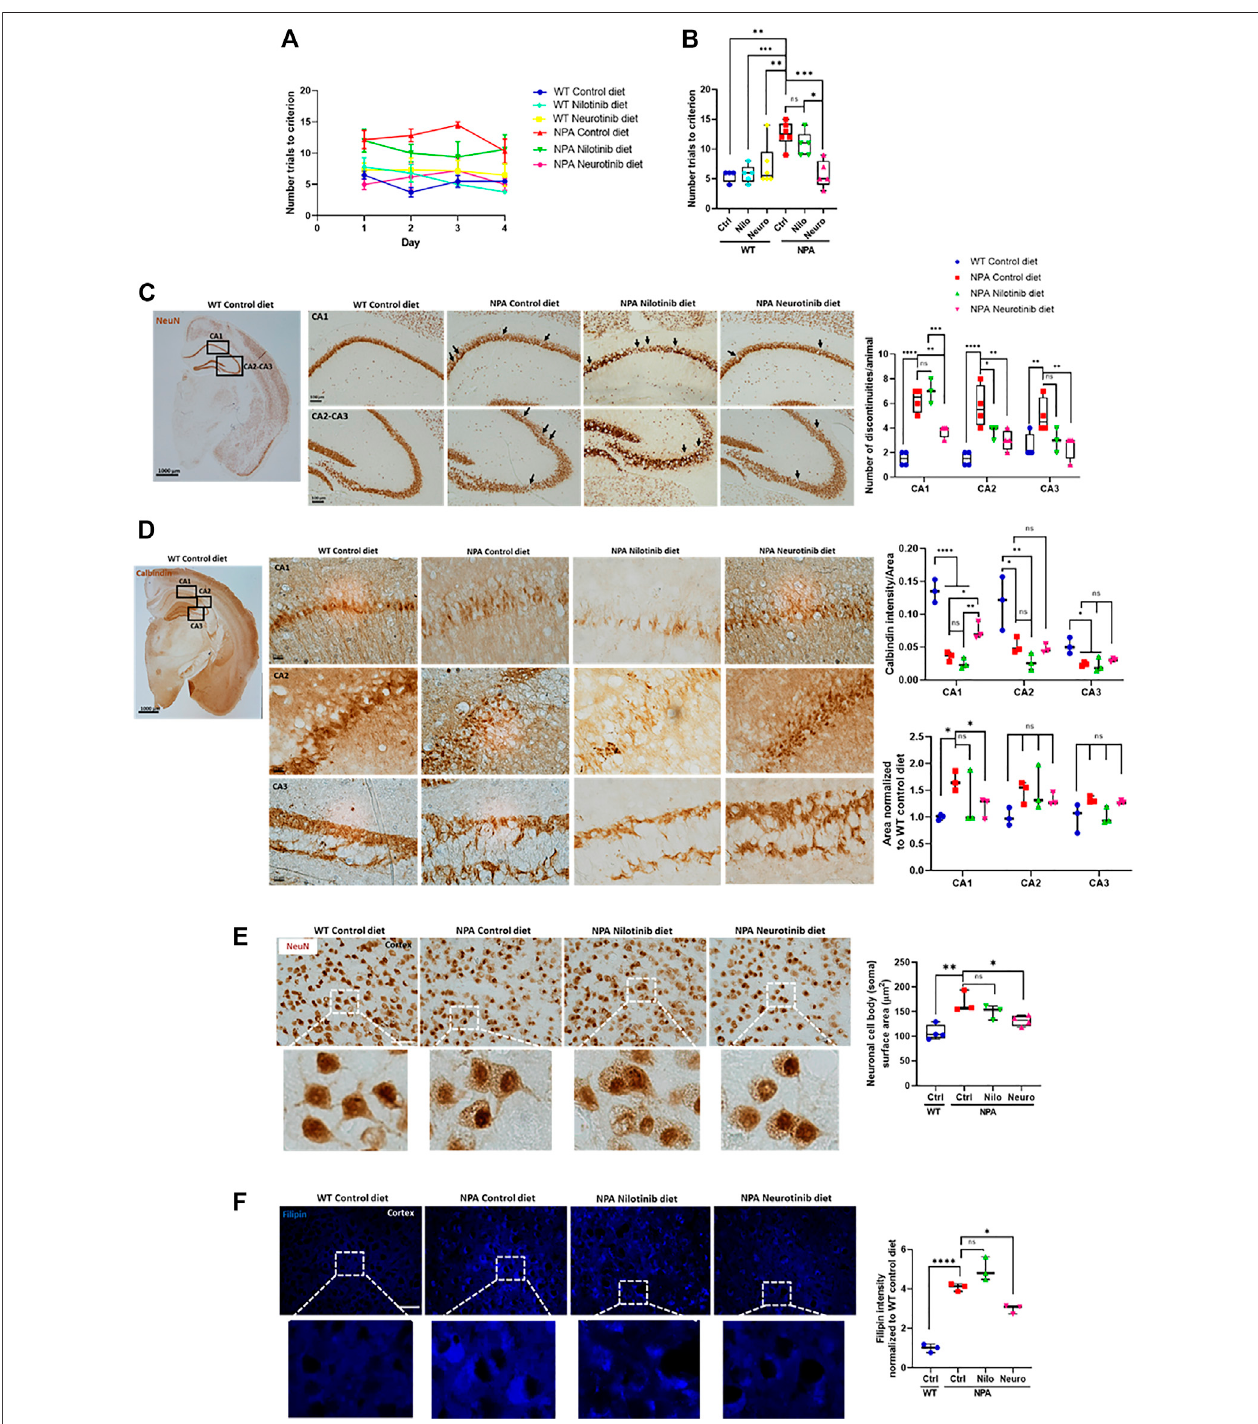
FIGURE 5 | Chronic c-Abl inhibition treatment improves cognitive decline and decreases brain neuronal disorganization in NPA mice. WT and NPA mice received nilotinib (200 ppm) and neurotinib (67 ppm) supplemented diets or control diet starting at p21 until 7 months of age. (A) Memory fl exibility test was used to evaluate cognitive functions. Graphs show the number of trials every day during the test (A) and the average among 4 days of test (B) . The number of animals was: WT control (Ctrl) diet = 4; WT nilotinib (Nilo) diet = 5; WT neurotinib (Neuro) diet = 6; NPA control diet = 6; NPA nilotinib (Nilo) diet = 5; NPA neurotinib (Neuro) diet = 5. ANOVA, Tukey post-hoc : * p < 0.05; ** p < 0.01; *** p < 0.001 (C) Coronal sections of WT and NPA brain were stained with anti-NeuN antibody and 3,39-diaminobenzidine as chromogen. The rectangles in the fi rst photo indicate where the magni fi cation shown in the following photos comes from. Arrows point to actual discontinuities. Graph bars indicating discontinuity differences between WT and NPA mice with treatment in hippocampal sub fi elds CA1, CA2, and CA3. Data are shown as the number of